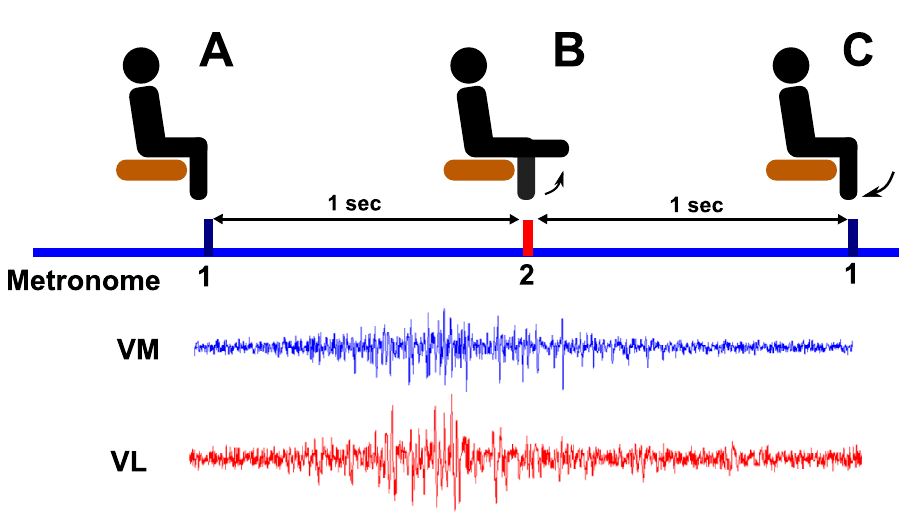
Fig 2. Illustration of the experimental protocol; The blue line marks the metronome cues. (A) cue 1, starting position, 90˚ knee angle. (B) cue 2, leg extension, 0˚ knee angle. (C) cue 1, return to starting position, 90˚ knee angle. The two data traces shown at the bottom are sampled at 2.4 kHz from the VM and VL,